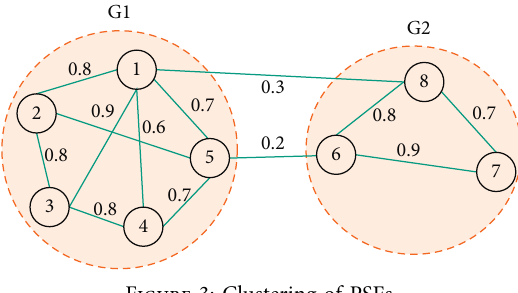
Figure 3: Clustering of